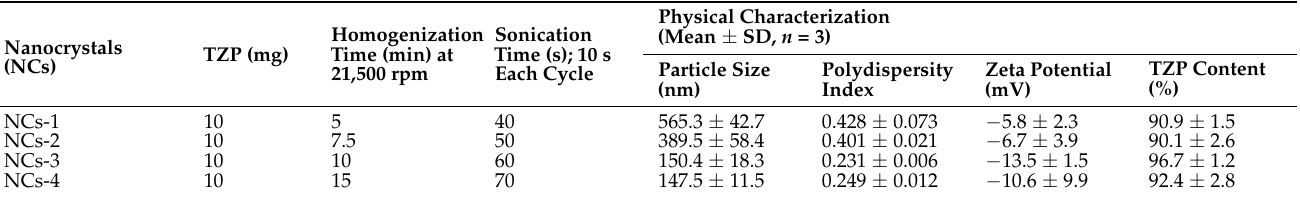
Table 2. Physical characterization of the NCs prepared using P188 at 1%, w / v (200 mg in each case) with varying durations of homogenization and probe sonication (Mean ± SD, n = 3) without mannitol.